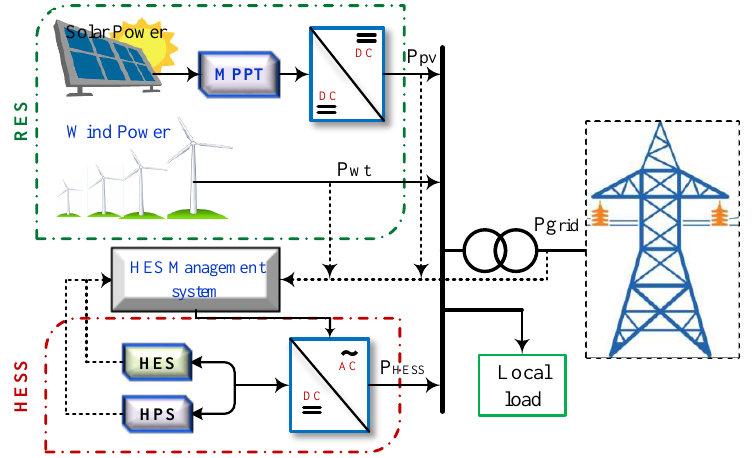
Figure 12. HESS for the improvement of the RES